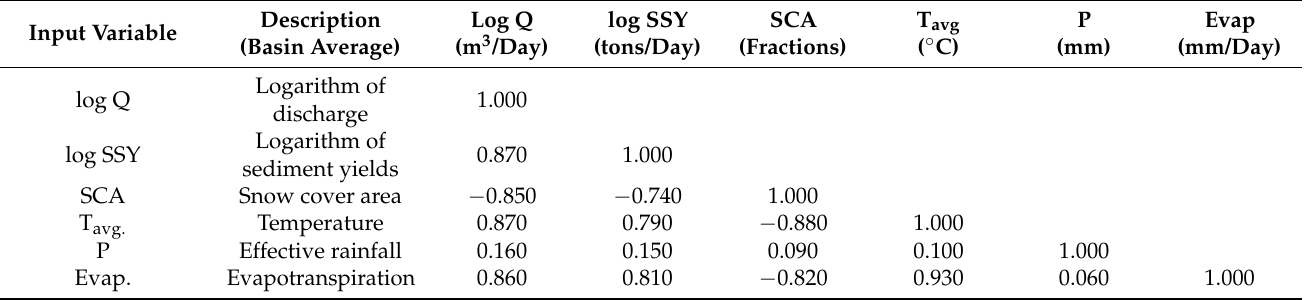
Table 2. Relationship between different input variables using Pearson’s correlation